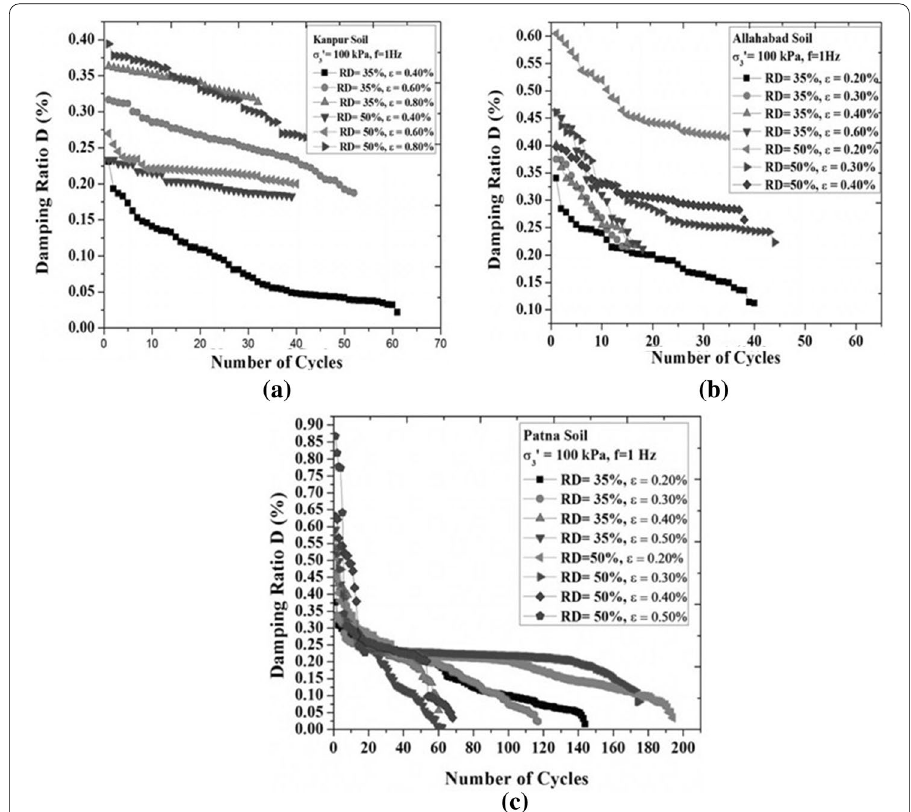
Fig. 12 Variation of damping ratio with relative density ( a ) Kanpur soil (RD 0.40%, 0.60%, 0.80%, effective confining pressure 50%, strain amplitude 0.20%, 0.30%, 0.40%, effective confining pressure = Patna soil (RD 35%, 50%, strain amplitude = 100 kPa, frequency 1 =